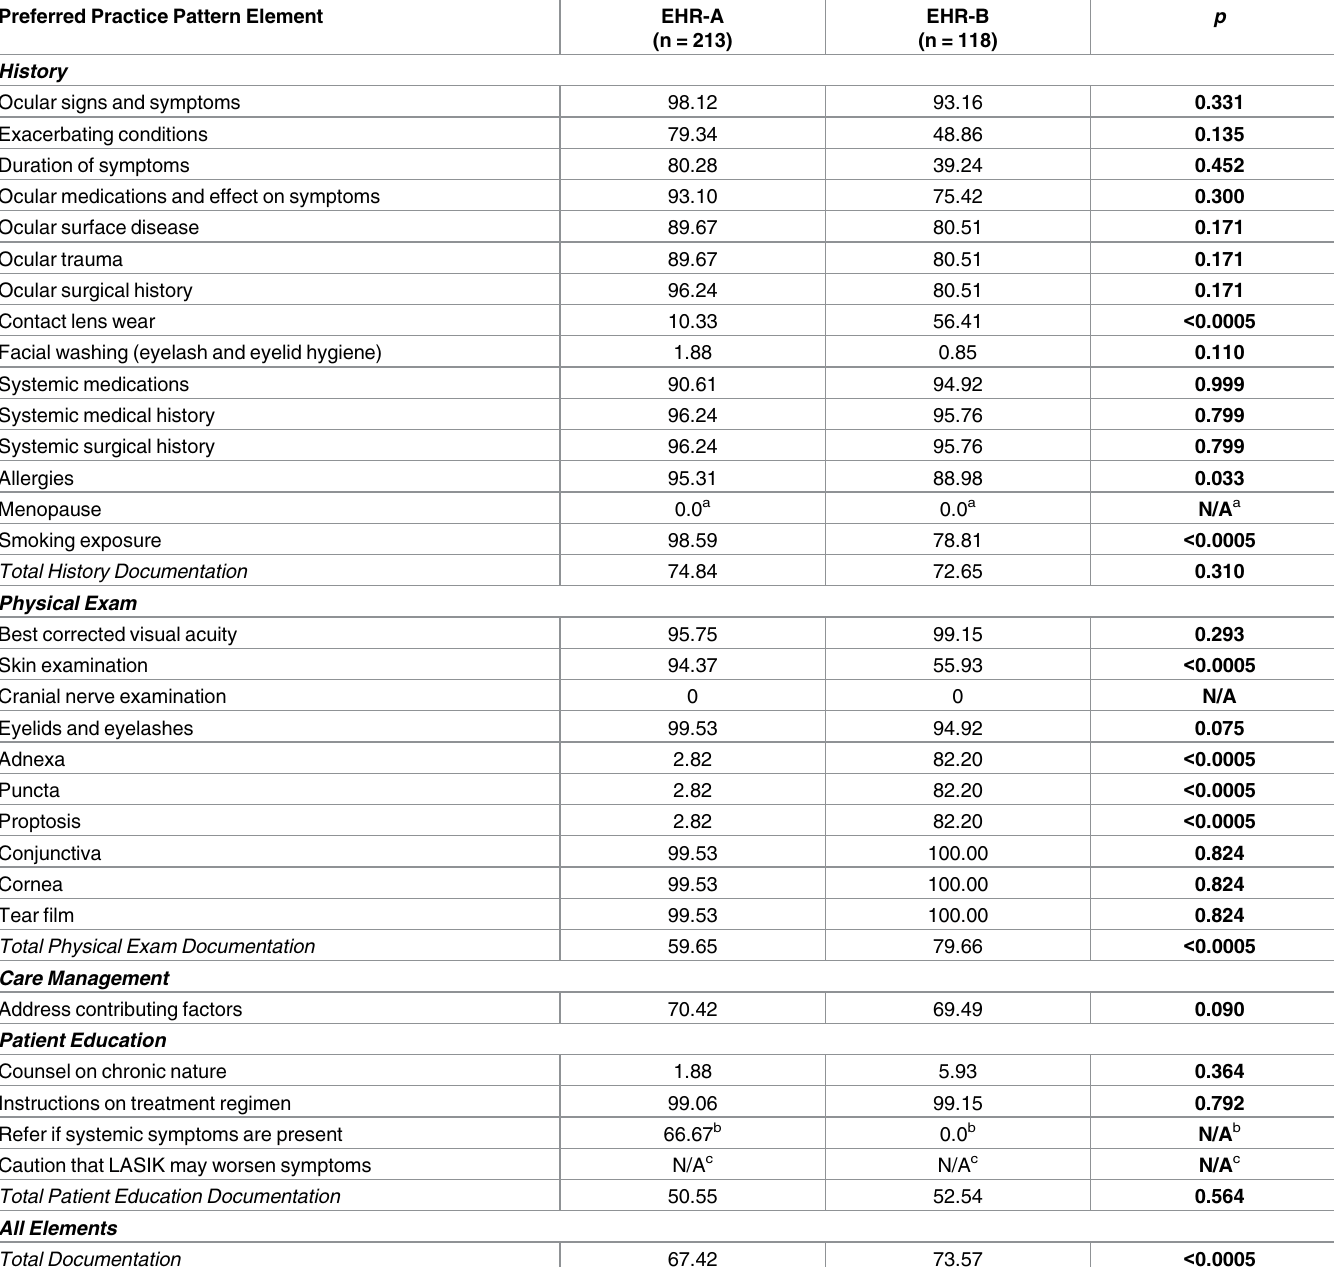
Table 3. Documentation percentage of different chart note template